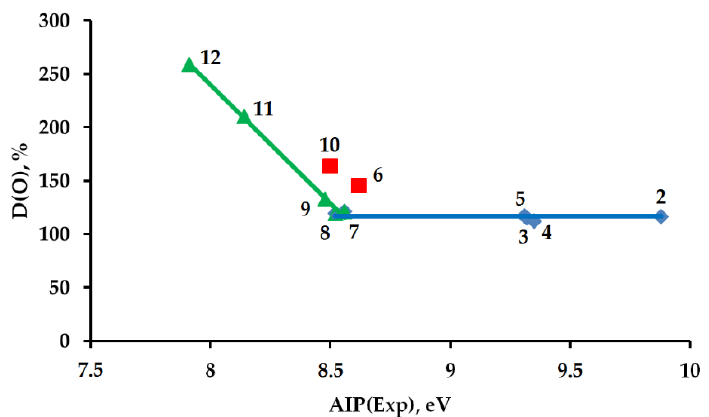
( RC ), bound lengths in Å.